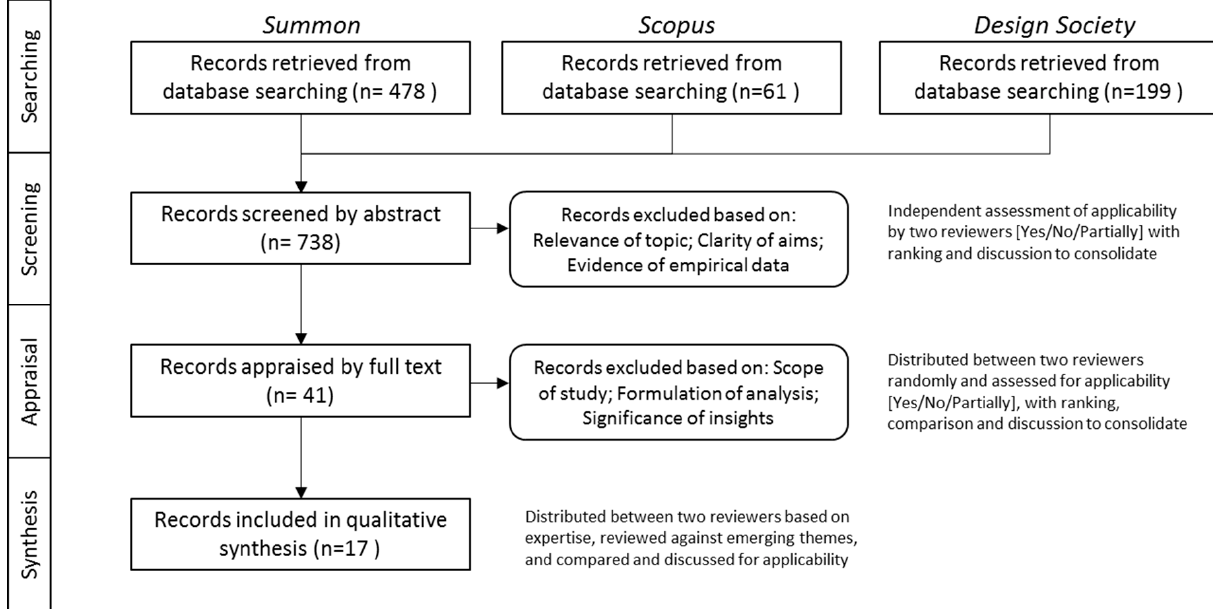
Figure 1. Flowchart summarizing approach to the selection and analysis of papers.